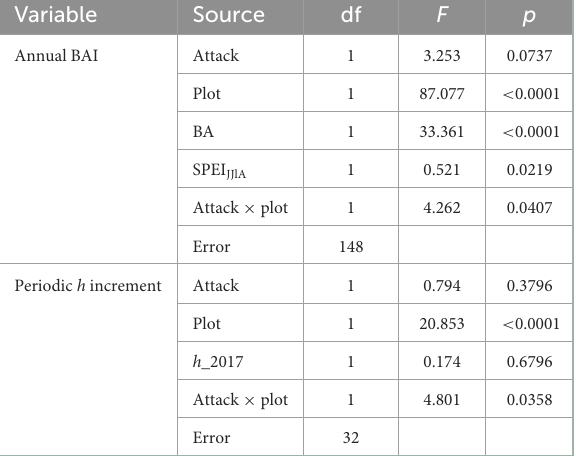
each plot at the beginning of our study were not significantly TABLE 2 ANOVA results testing for patterns in annual BAI and periodic